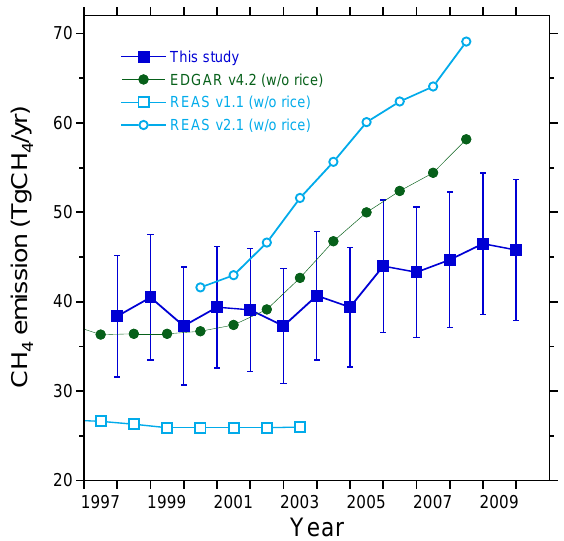
Table 1. Summary of the estimated CH 4 and CO emissions from China a .